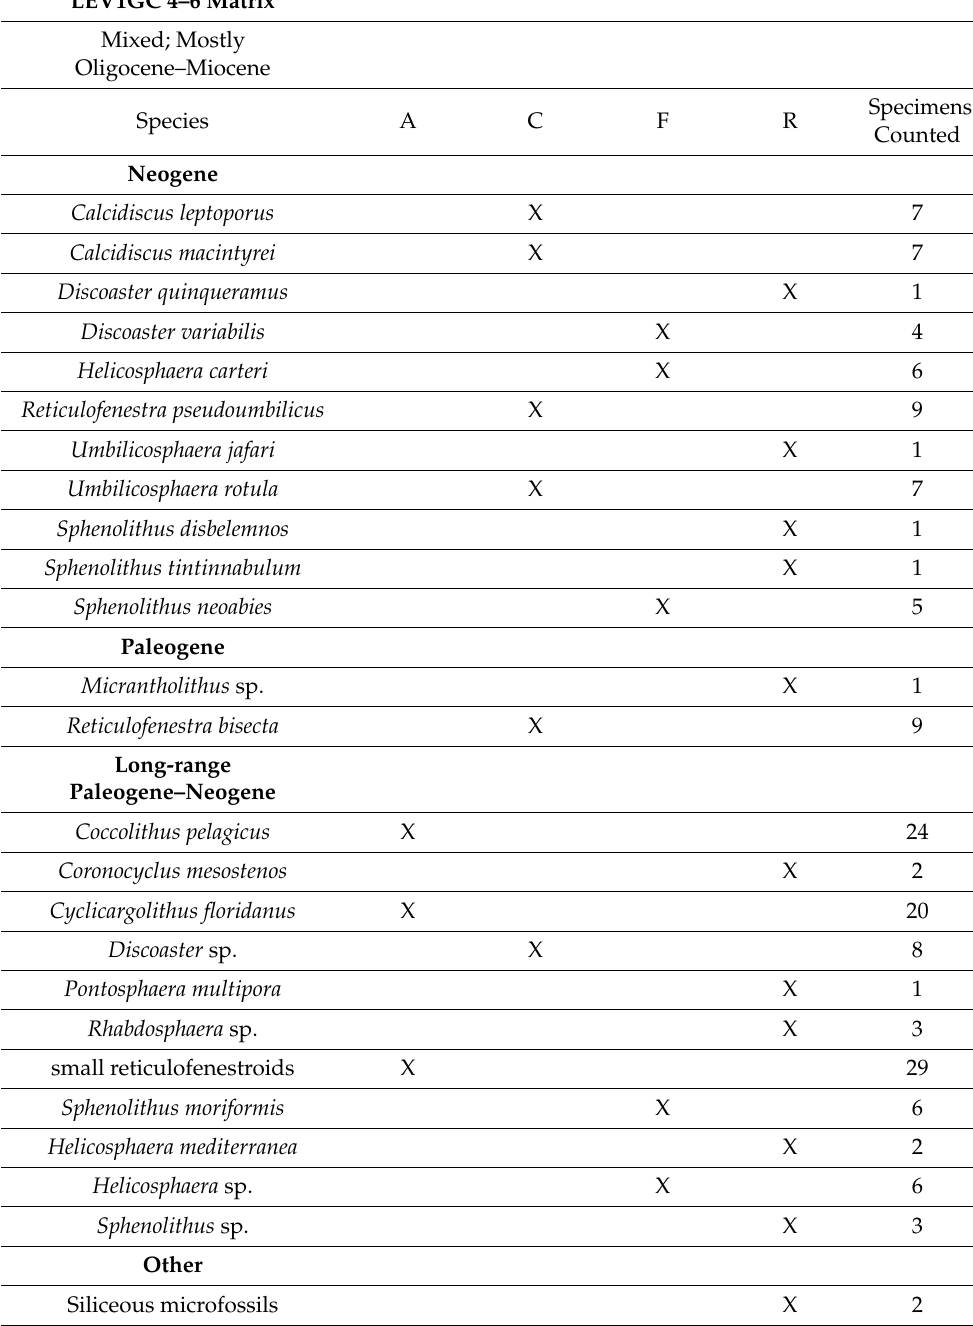
Table A6. Gelendzhik